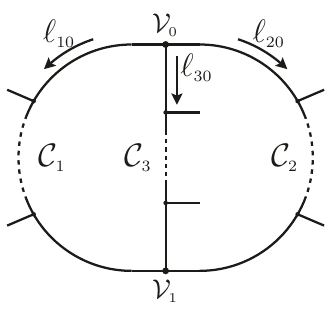
Figure 2 . A generic irreducible two-loop diagram consists of two vertices, , , that connect three V 0 V 1 chains, , , , which contain, respectively, all propagators that depend on the loop momenta q 1 , C 1 C 2 C 3 q q q q ‘ i q i + p i 2 , 3 = (cid:0) 1 (cid:0) 2 . For the sum of the loop momenta 0 = 0 , which (cid:13)ow out of V 0 , momentum P ‘ i p i k k conservation requires P 0 = 0 = ext , where ext is the external momentum that (cid:13)ows into i i . In practice, if is a triple vertices (as in the picture) then k ext = 0 and all p i 0 can be set equal V 0 V 0 to zero, while quartic vertices requires at least one non-vanishing p i 0